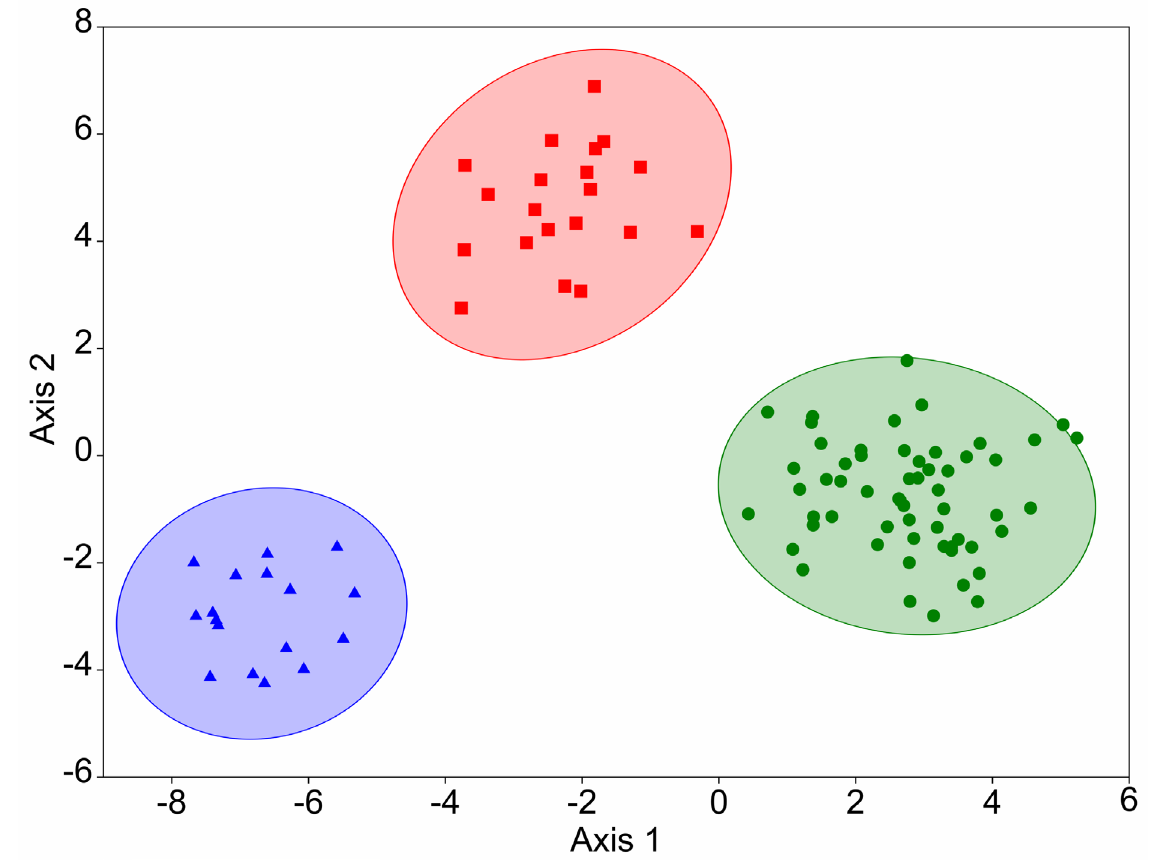
Fig. 5. The result of the DFA carried out on morphometric characters to discriminate Cottus cyclophthalmus sp. nov. (green), Cottus gobio Linnaeus, 1758 (blue), and Cottus koshewnikowi Gratzianov, 1907